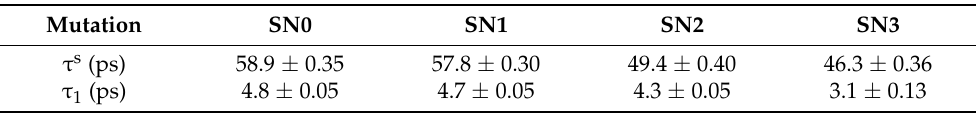
Table 4. Fitting results for C r ( t ) in mutations. The uncertainty is the mean square deviation between the raw data and the best fitting